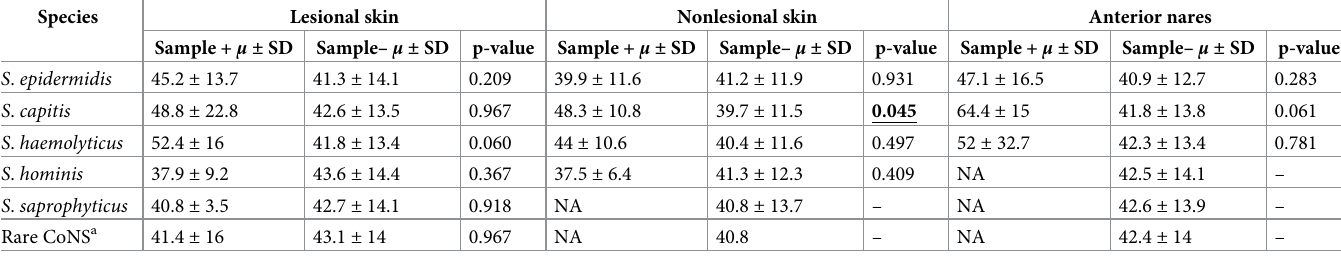
NA represents observations that are too few for mean and standard deviation calculation. Sample +, CoNS present; Sample -, CoNS absent; μ , mean; SD, standard deviation. Underlined bold text indicates statistical significance. P- values were determined using the Wilcoxon rank-sum test. a Rare CoNS include S . caprae , S . cohnii , S . equorum , S . lentus , S . lugdunensis , S . nepalensis , S . pasteuri , S . sciuri , S . succinus and S . warneri .